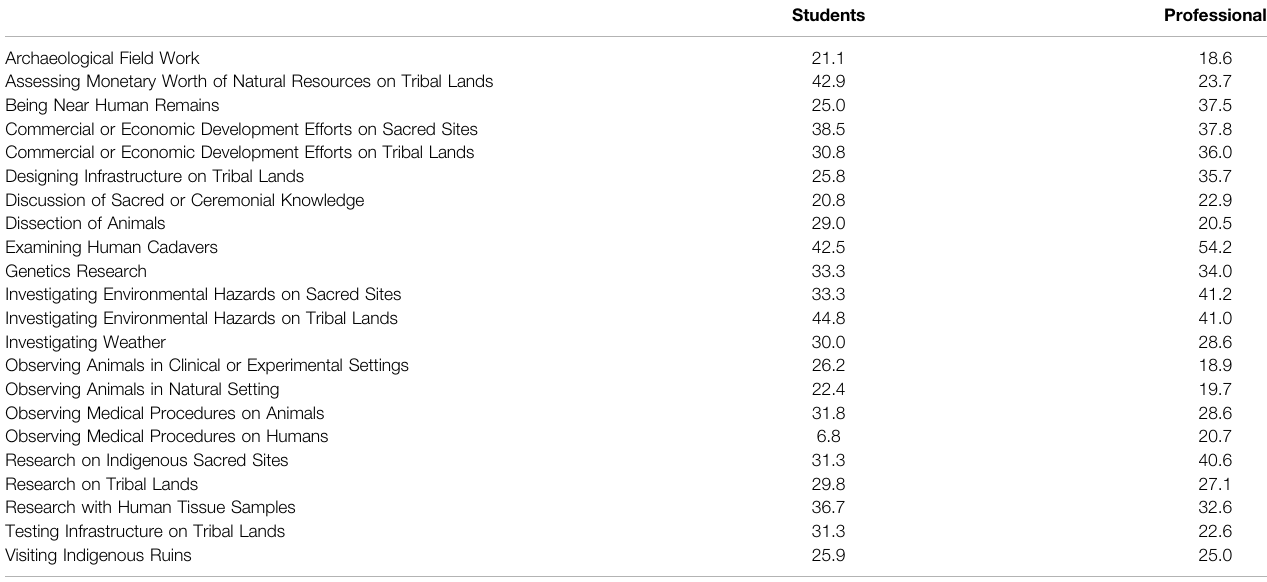
TABLE 2 | STEMM task – percentages of very concerning responses.